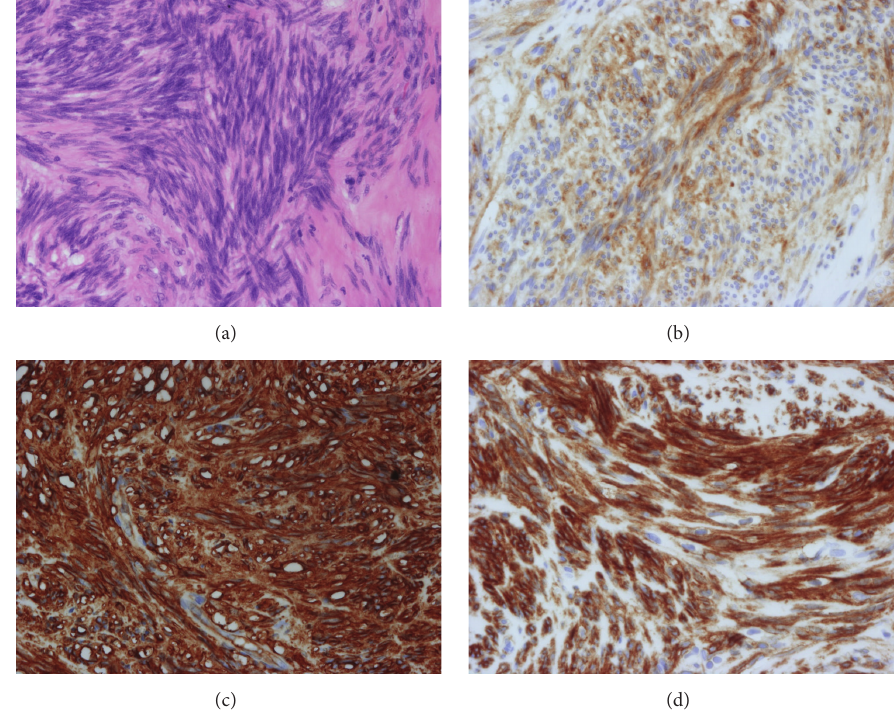
Figure 4: Histopathological analysis. (a) The tumors consisted of spindle cells. (b) Positive for KIT (CD117). (c) Positive for CD34. (d) Positive for